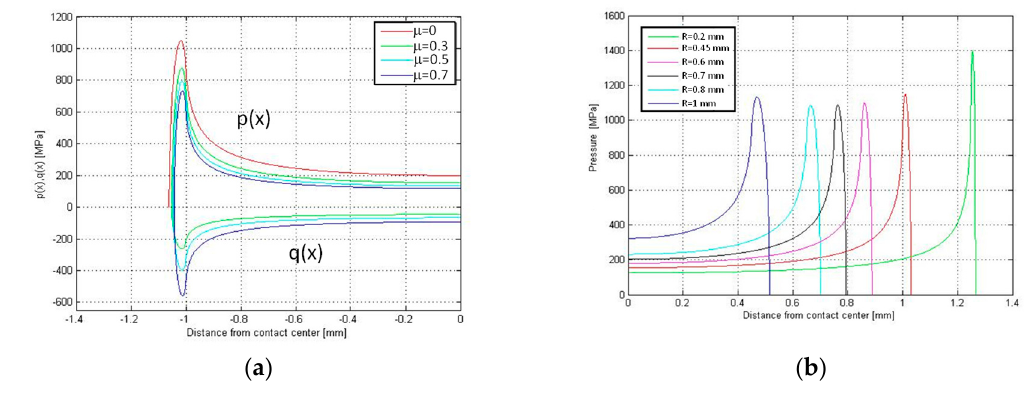
Figure 9. Analytical model of test # 2: ( a ) contact normal (p) and tangential (q) pressure for different friction coefficients; ( b ) normal contact pressure as a function radius of the external end of the disk slot.